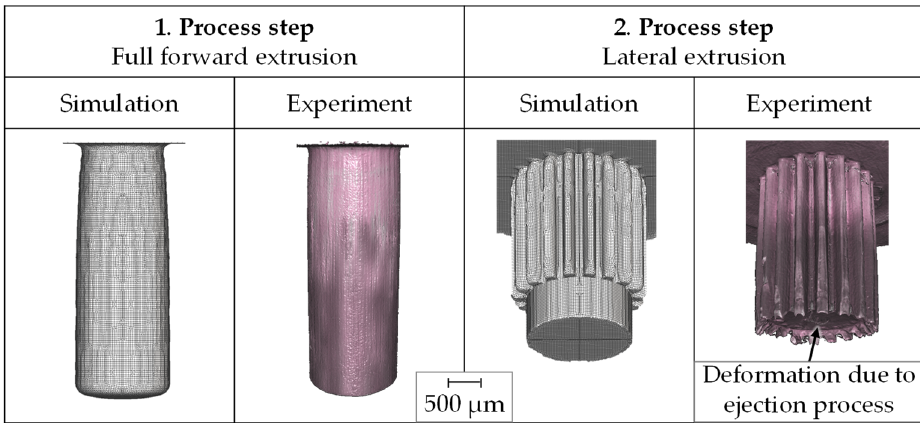
Figure 3. Numerically and experimentally determined geometries.